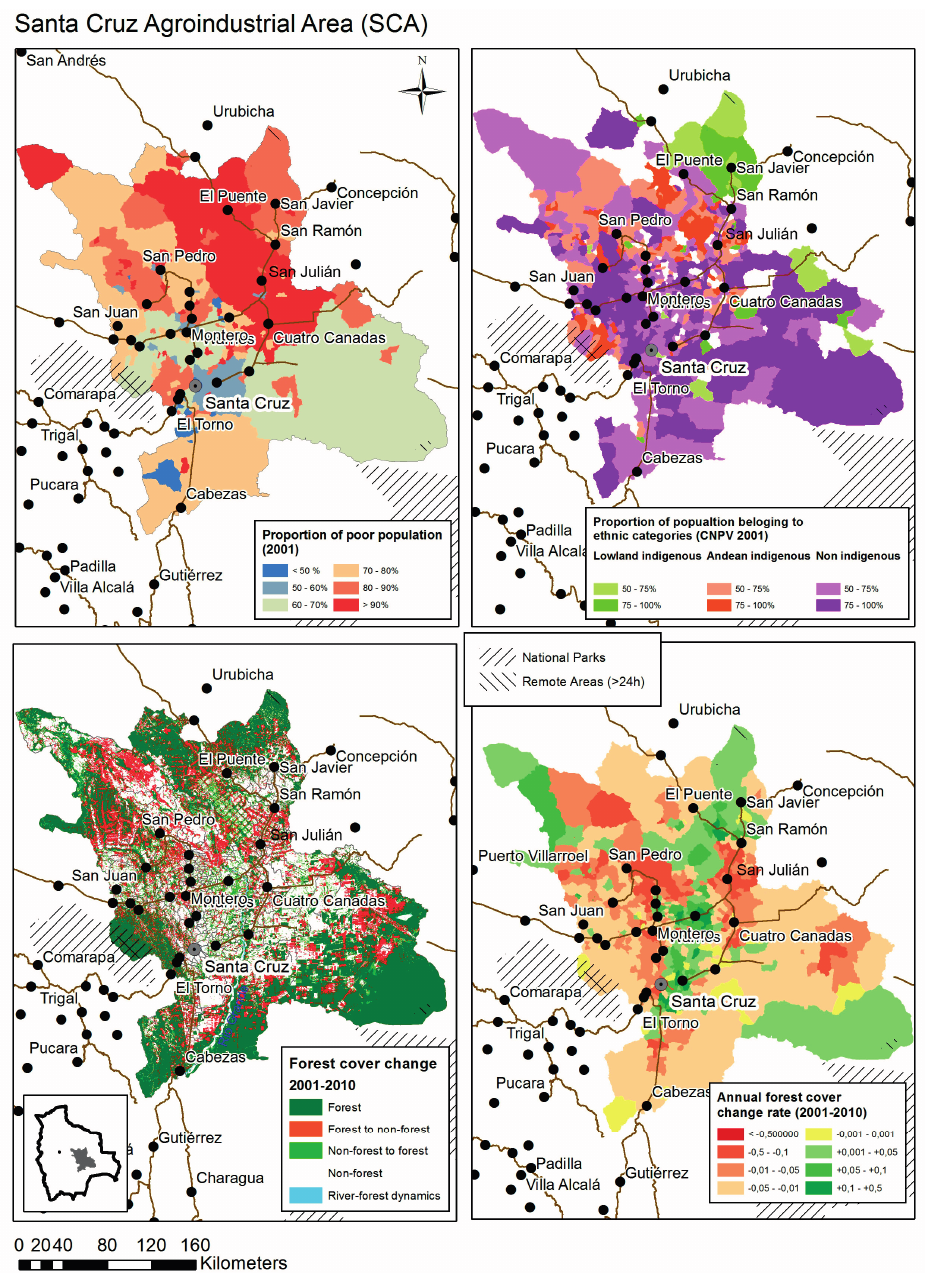
Figure 5. Poverty, ethnic groups and forest cover change in the Santa Cruz agroindustrial